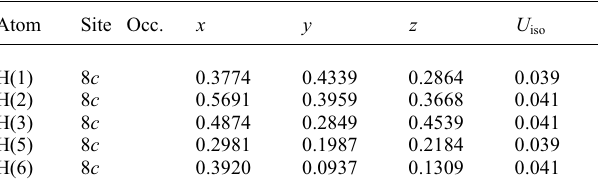
Table 2. Atomic coordinates and displacement parameters (in Å 2 )